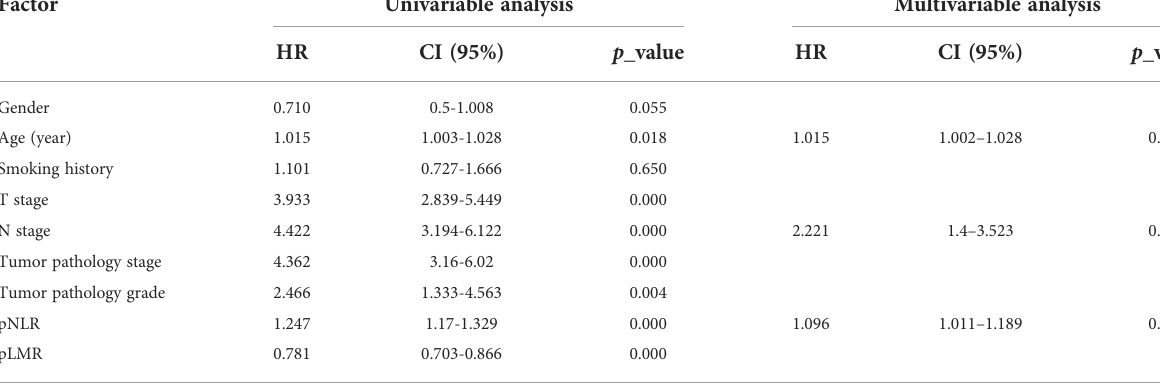
TABLE 1 Univariable and multivariable Cox regression of the correlation factors of survival. Factor Univariable analysis Multivariable